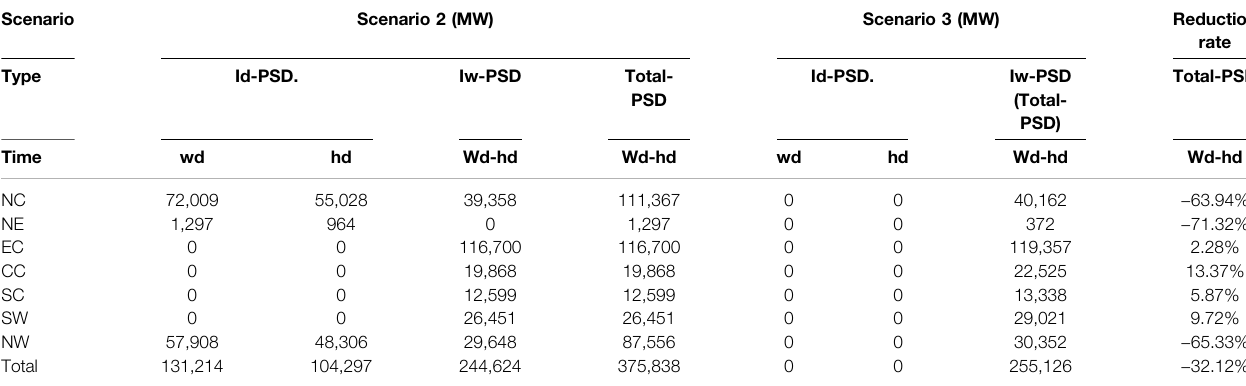
TABLE 5 | | Start-stop peak shaving capacity demand (SS-PSD) in each region. Scenario